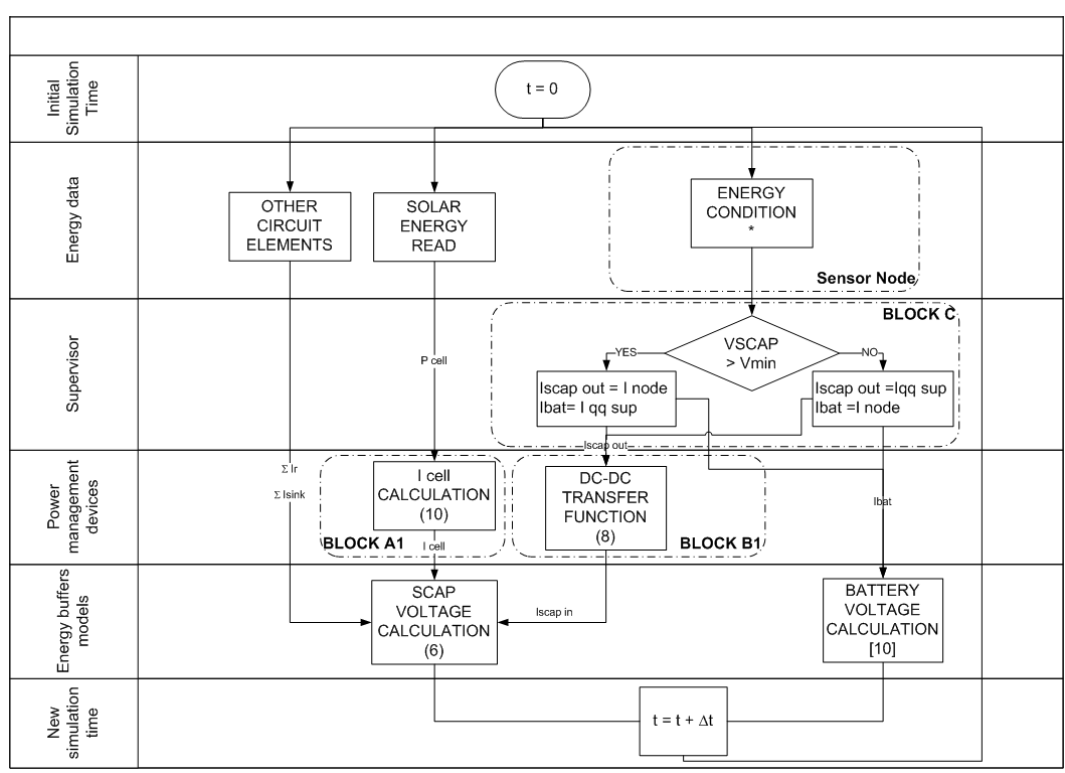
Figure 4. SIVEH flow